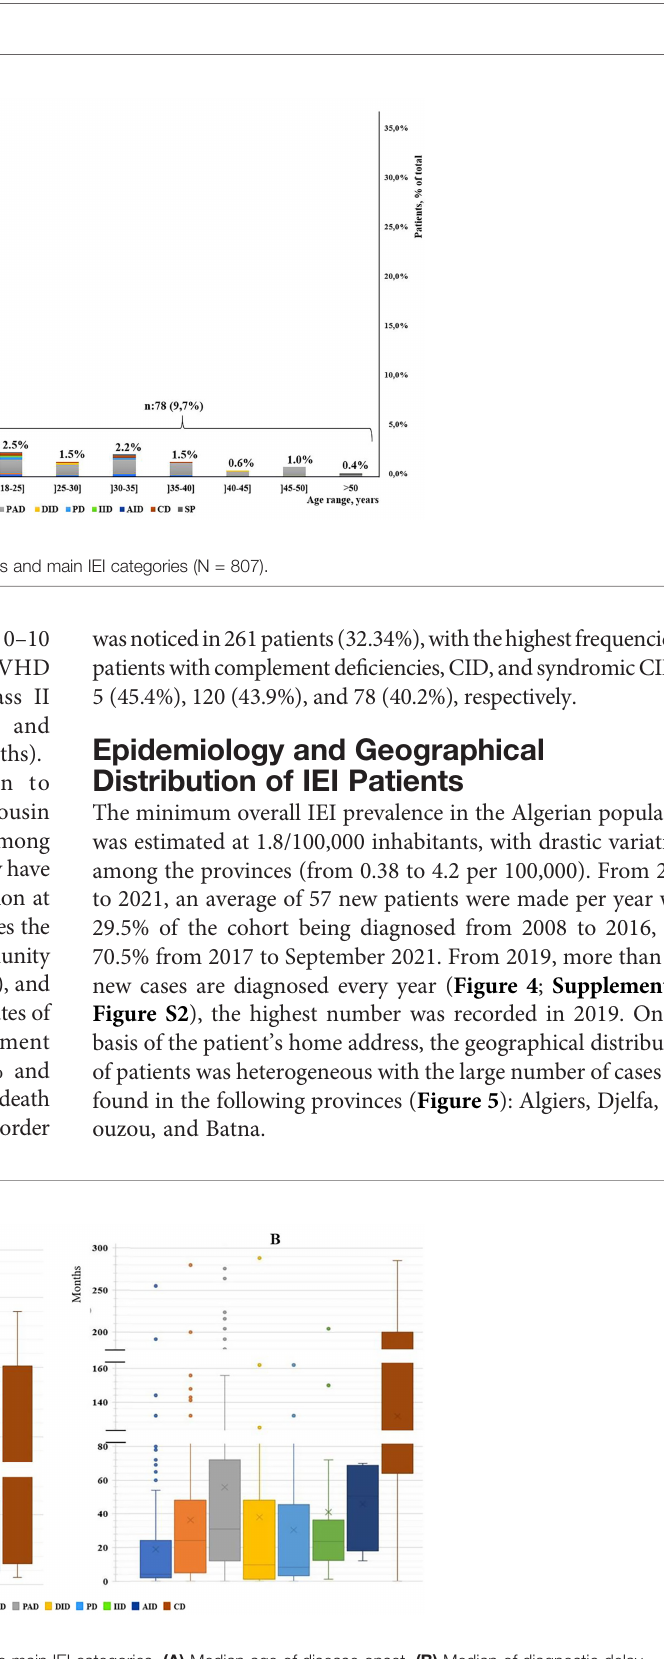
FIGURE 3 | The median age of disease onset and diagnostic delay in the main IEI categories. (A) Median age of disease onset. (B) Median of diagnostic